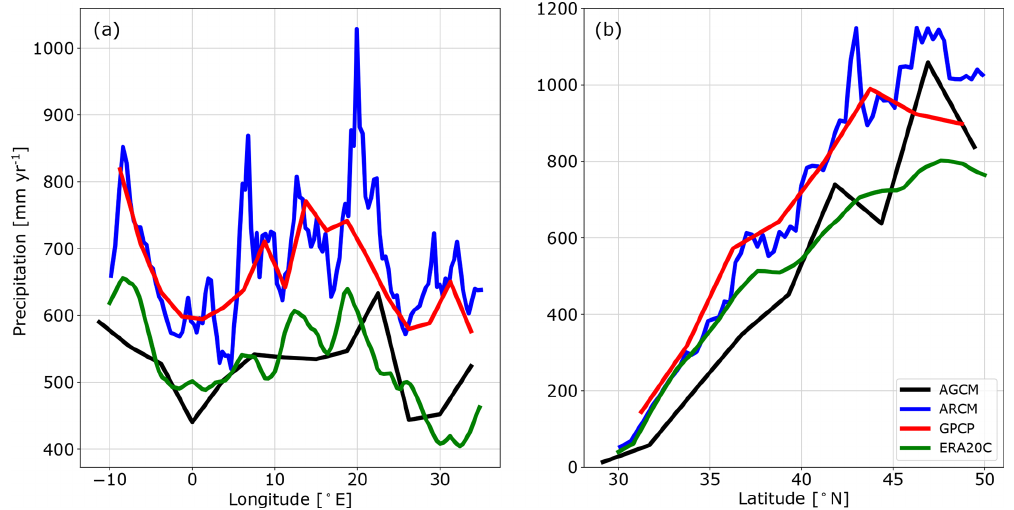
Figure 3. Annual mean precipitation, (a) meridionally averaged (30 to 50 ◦ N), (b) zonally averaged ( − 10 to 35 ◦ E), in the historical sim- ulations with an AGCM (LMDZ-global) and ARCM (LMDZ-regional). Observation comes from GPCP (Global Precipitation Climatology Project, 1979 to 1999, blue line; Adler et al., 2018) and ERA-20C (green line; Stickler et al.,